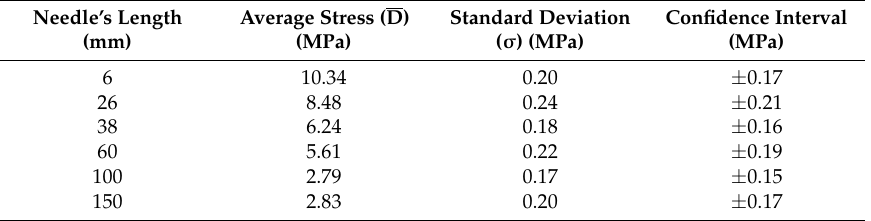
Table 4. The relationship between needle length and the maximal puncture stress of nanofiber membrane. Needle’s Length (mm)